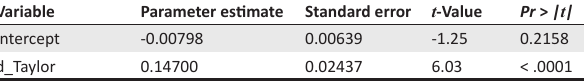
TABLE 3: Model 2: Dependent variable: Interest rates analysis of variance. Variable Parameter estimate Standard error t -Value